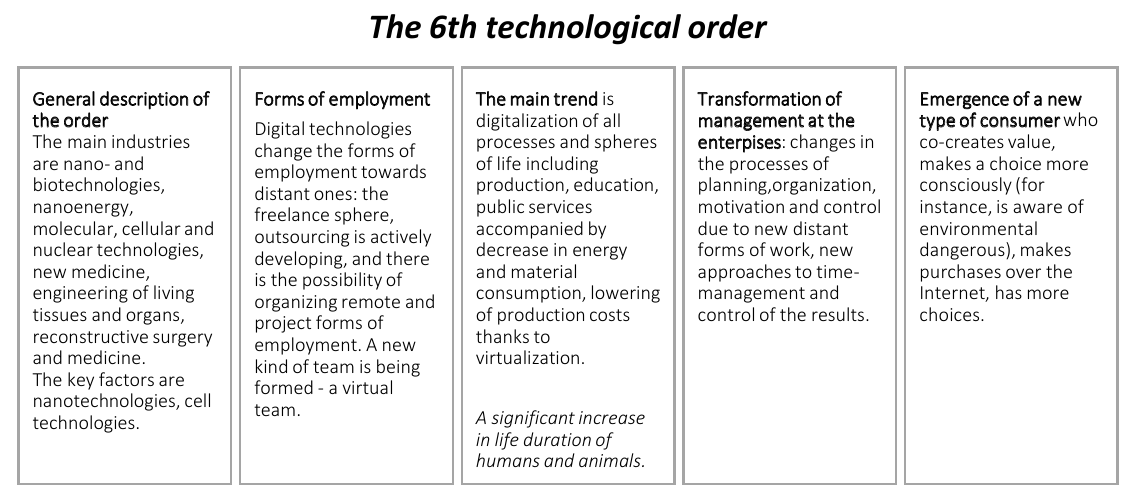
Figure 1. Characteristics of the fifth and the sixth technological